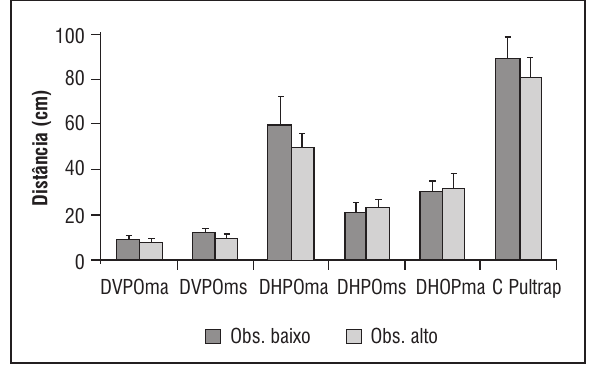
Figura 3 - Médias e desvios padrão da distância vertical pé/ obstáculo (DVPO), distância horizontal pé/obstáculo (DHPO), distância horizontal obstáculo/pé (DHOP), do membro de abordagem (ma) e do membro de su- porte (ms) e comprimento do passo de ultrapassa- gem (CPultrap), nas condições de obstáculo Fonte: Dados da